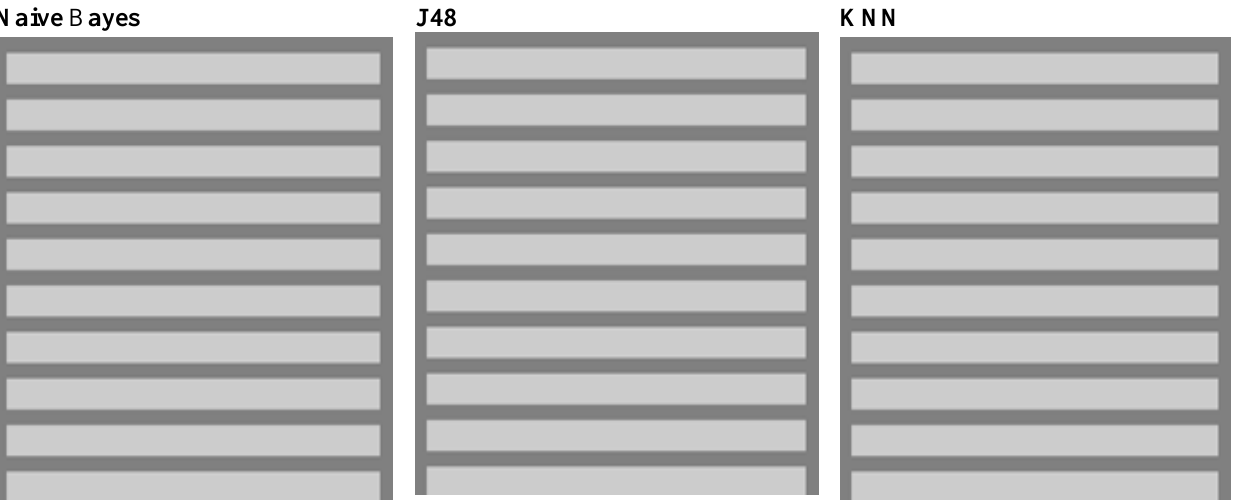
Figure 2. Main interface of the system classification